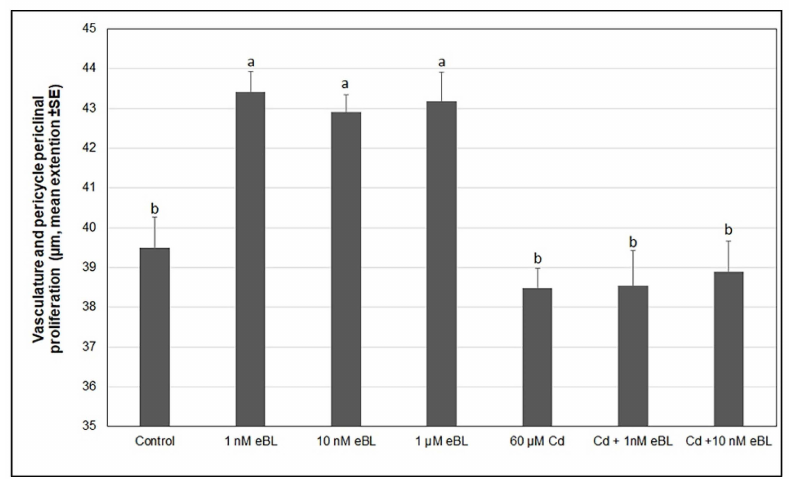
Figure 4. Pericycle periclinal proliferation in the basal hypocotyl of A. thaliana (Col ecotype) seedlings cultured for 9 days under continuous darkness followed by 7 days under 16 h light/8 h darkness photoperiod on 1/2 MS medium (control treatment) or on the same medium added with either 1 nM of 24-epibrassinolide (eBL), or 10 nM eBL, or 1 µ M eBL, or 60 µ M CdSO 4 (Cd), or Cd + 1 nM eBL or Cd + 10 nM eBL. Letters show significant differences for at least p < 0.01. The same letter shows no significant difference. N = 30. Data from the first replicate.